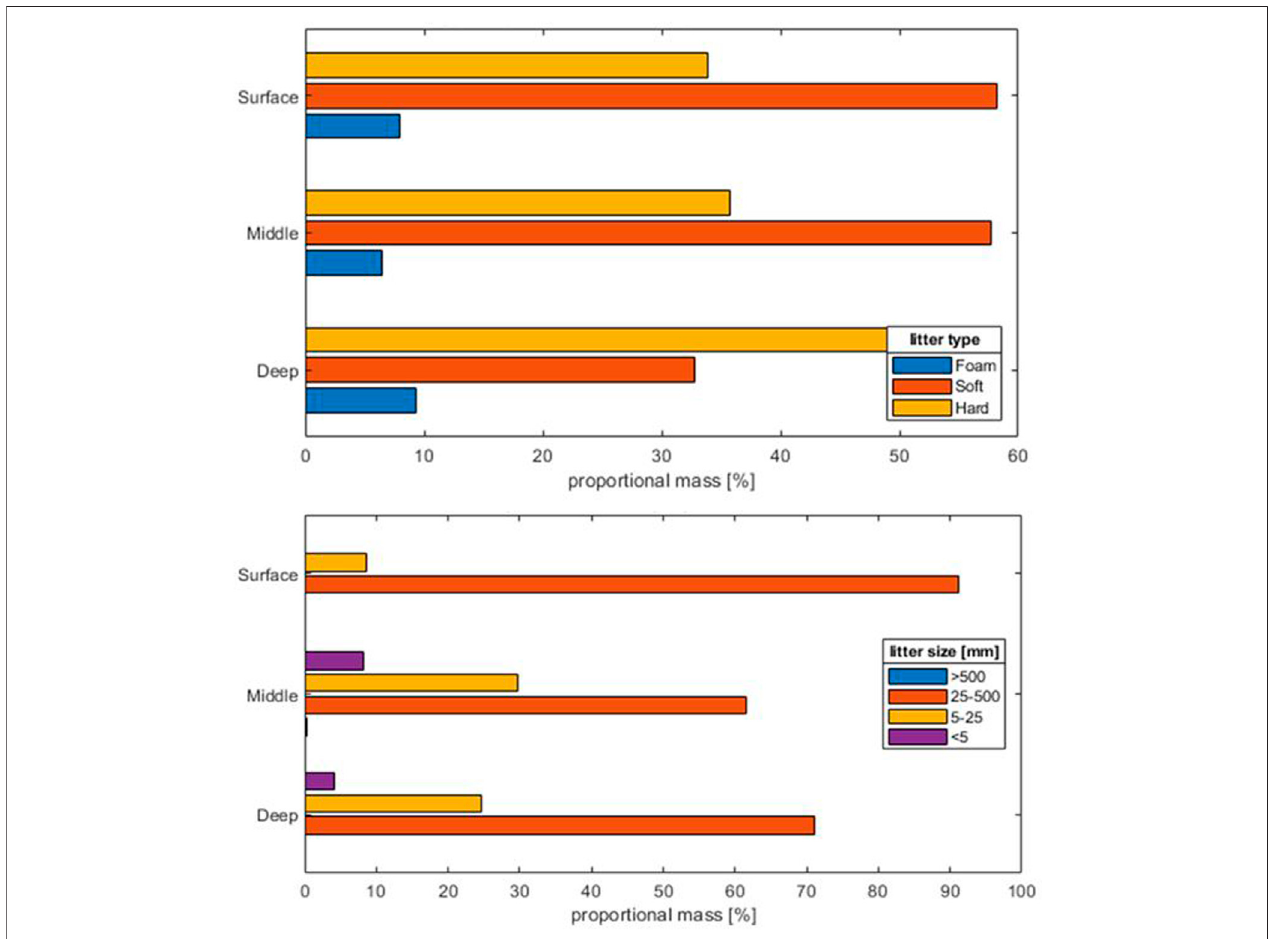
FIGURE5| Thecompositionoftheplasticlitteraveragedoverthe28surveys,showing[top]thedistributionovertheplasticcategoriesand[bottom]thedistribution over the four size fractions.